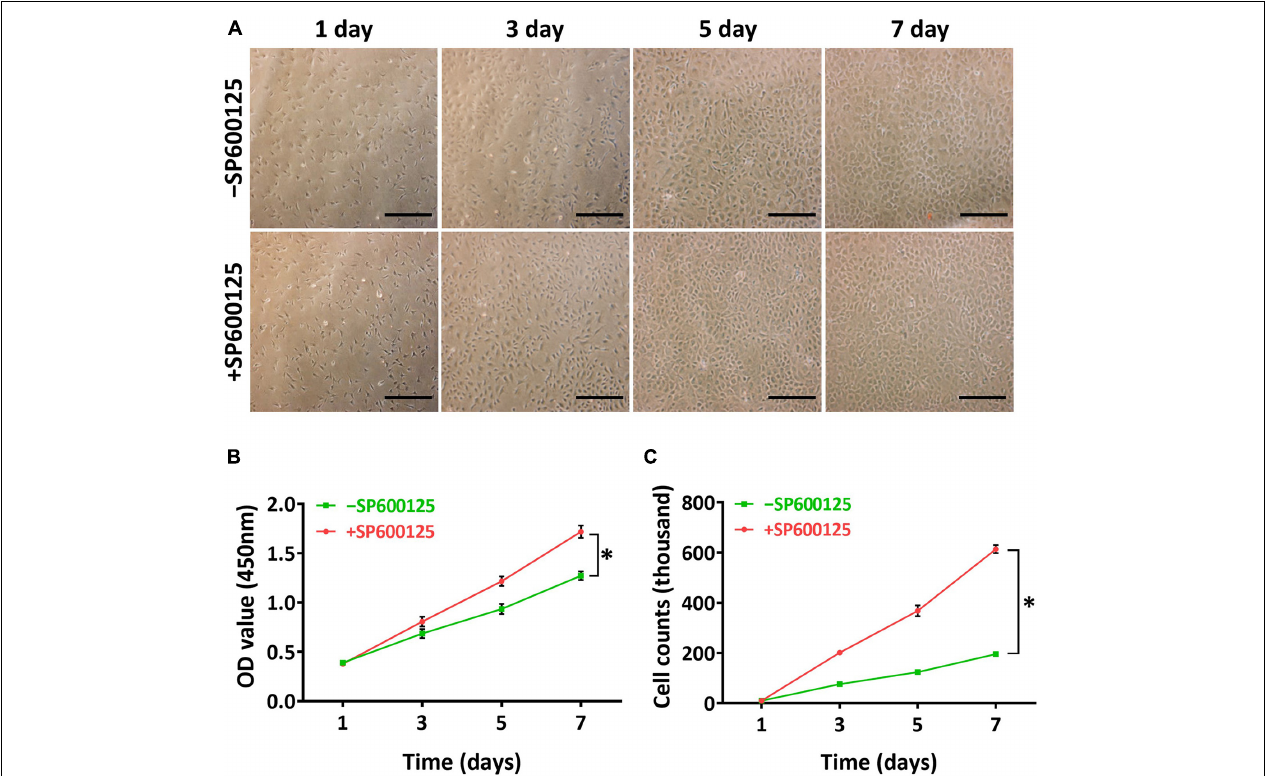
FIGURE 1 | Influence of SP600125 on auricular chondrocyte proliferation. Chondrocyte proliferation was observed by light microscopy (A) , CCK-8 (B) , and cell counts (C) . The + SP600125 culture system promoted the proliferation of chondrocytes compared with the -SP600125 culture system as shown consistently by light microscopy, CCK-8 assays, and cell counts. Scale bars = 50 µ m. “*”indicates statistical significance ( p < 0.05). CCK-8, cell counting kit 8; JNK, c-Jun N -terminal kinase.